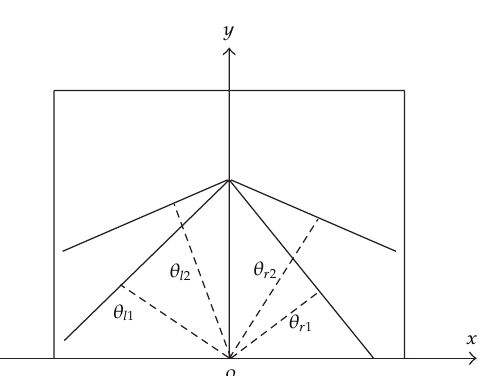
Figure 8: Diagram of angular relationship for multilane.